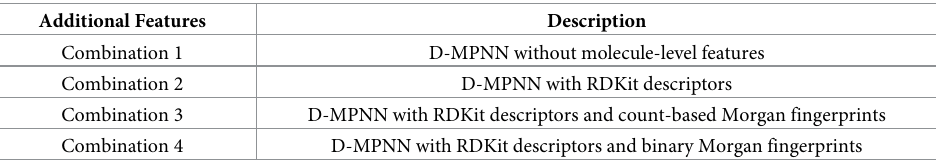
Table 1. Deep learning models trained with different combinations of molecule-level